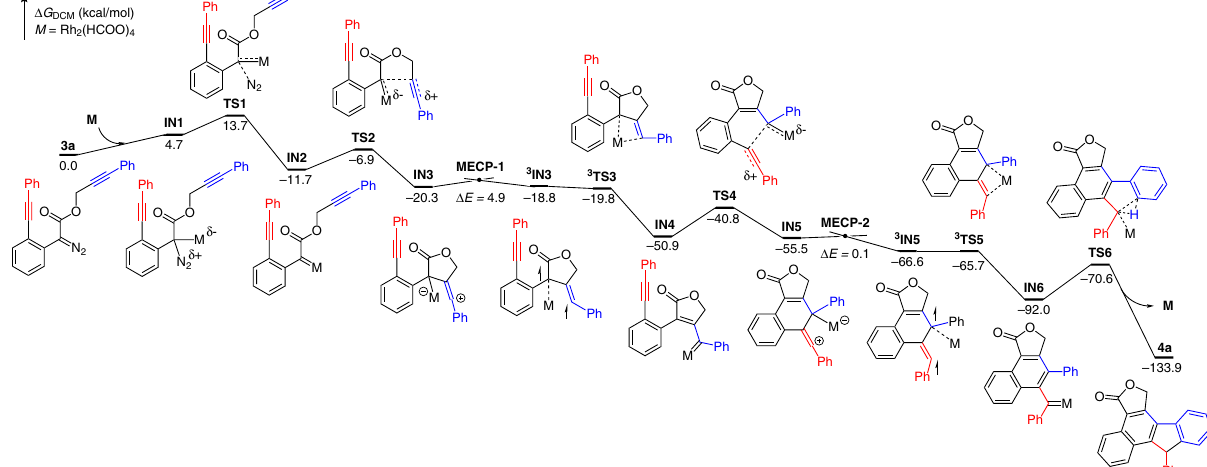
Δ G DCM (kcal/mol) M = Rh 2 (HCOO) 4